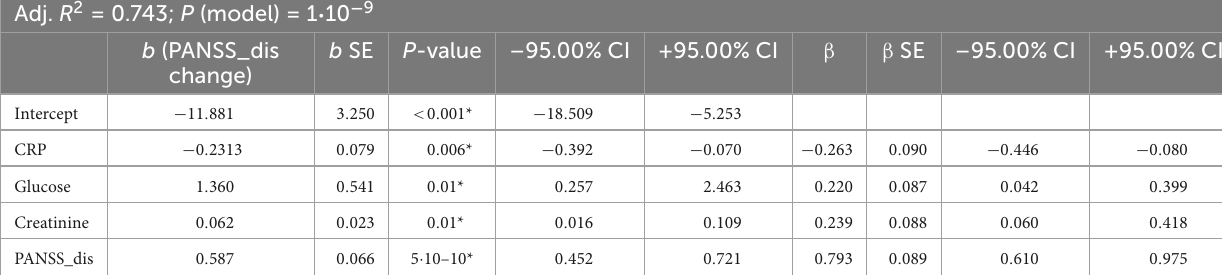
TABLE 2b Results of stepwise linear regression analyses for subscales of the Positive and Negative Syndrome